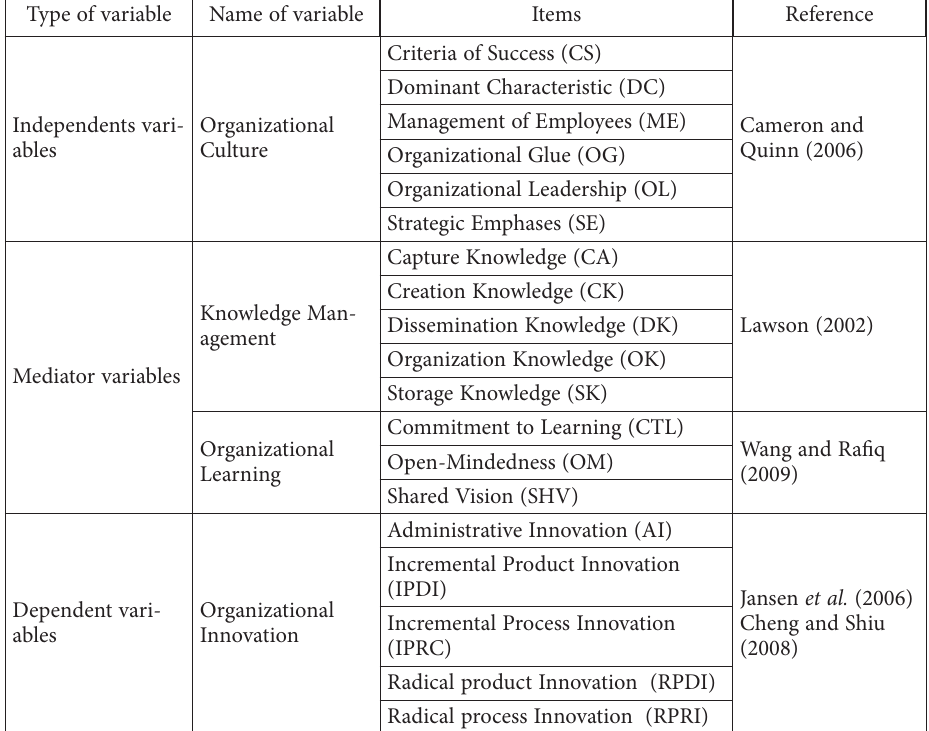
Table 3. Details of all